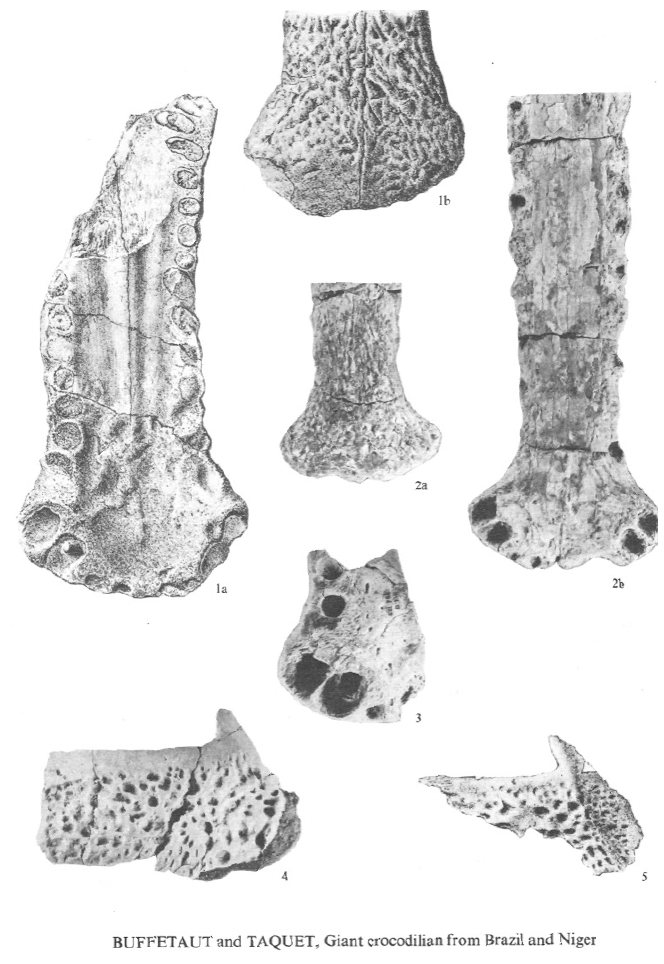
Figure 1. Sarcosuchus remains from Brazil and Niger: 1. Sarcosuchus hartii , from Brazil; anterior extremity of lower jaw (from Mawson and Woodward 1907); a, in dorsal view; b, in ventral view. 2. Sarcosuchus imperator , from Niger. 2, anterior extremity of lower jaw of young individual; a, in ventral view; b, in dorsal view. 3, anterior extremity of right dentary of adult specimen, in dorsal view. 4. Sarcosuchus imperator from Niger, dorsal scute. 5. Sarcosuchus hartii , from Brazil, dorsal scute (from Mawson and Woodward